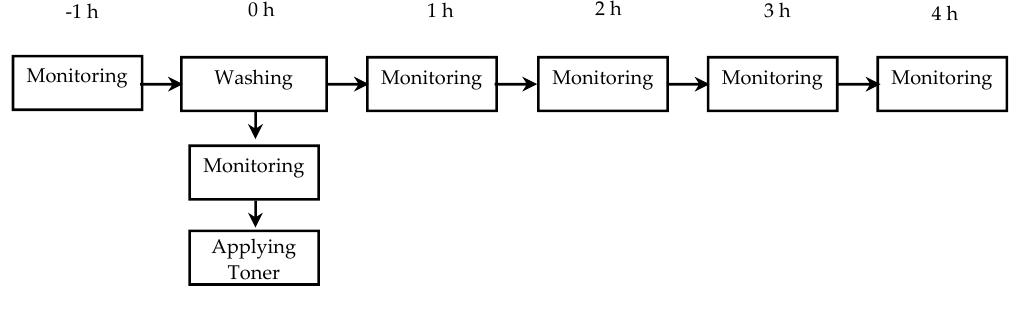
Figure 2. Steps in the experiment.